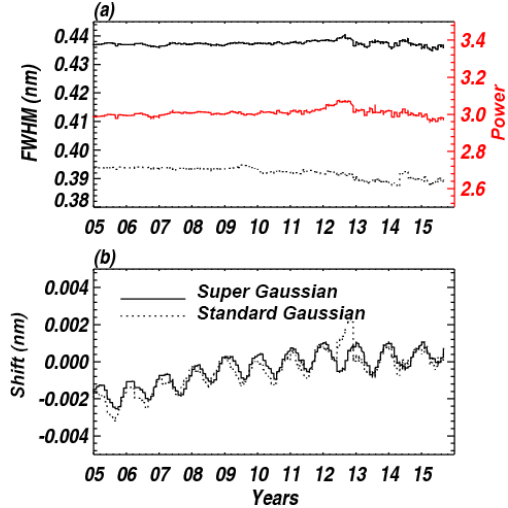
Figure 1. Time series of (a) slit parameters and (b) wavelength shifts for OMI daily irradiance measurements (310–330nm) at nadir cross-track position when super Gaussians (solid line) and standard Gaussians (dotted line) are parameterized as slit function